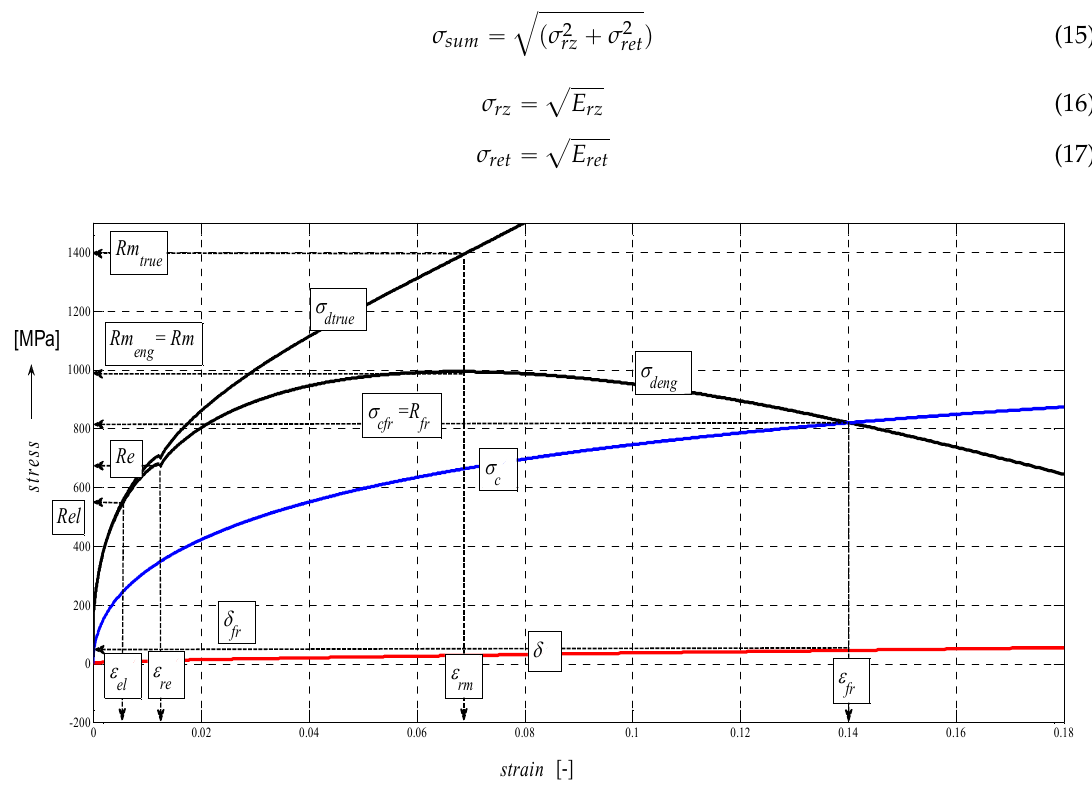
Figure 9. Diagram for STN 15230 steel, dependence of functions on relative elongation.